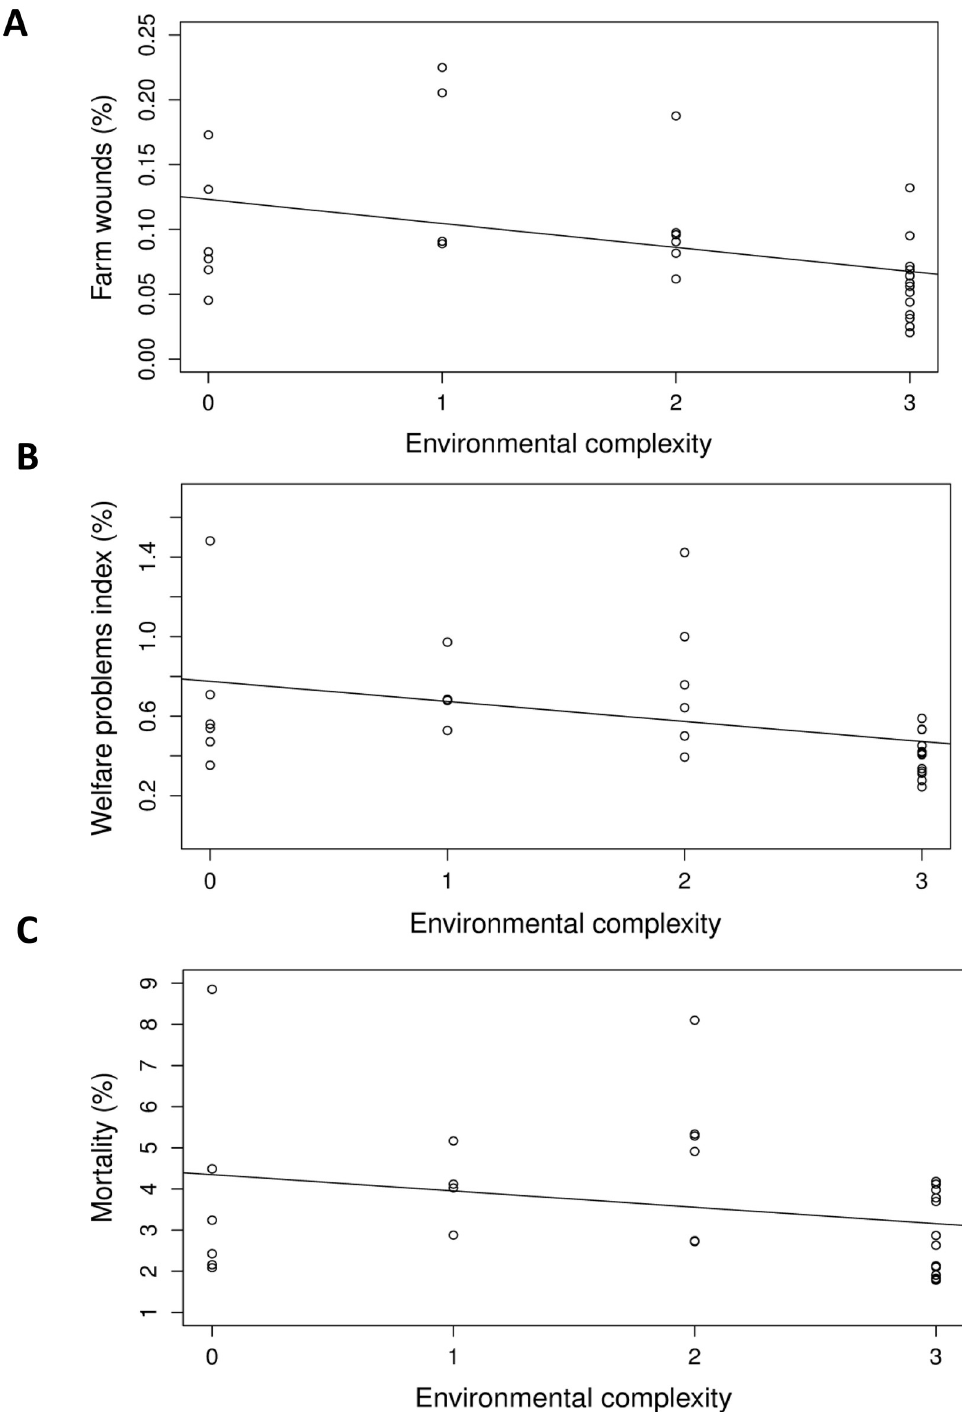
Fig 1. Associations of environmental complexity with (A) skin wounds (r 2 = 0.183), (B) welfare problems index (r 2 = 0.164), and (C) mortality (r 2 = 0.074). Environmental complexity is based on the number of environmental enrichment types (boxes, peat, wood shavings bales) provided (from 0–3). Data points are back-transformed estimates. (A, B) Birds detected with skin wounds, and sum of birds detected with welfare problems (walking difficulties, illness, skin wounds, small size), as a % of the estimated number of birds in 4 assessed transects. (C) Number found dead and culled on the farm up to the day of slaughter as a % of number of chicks started.